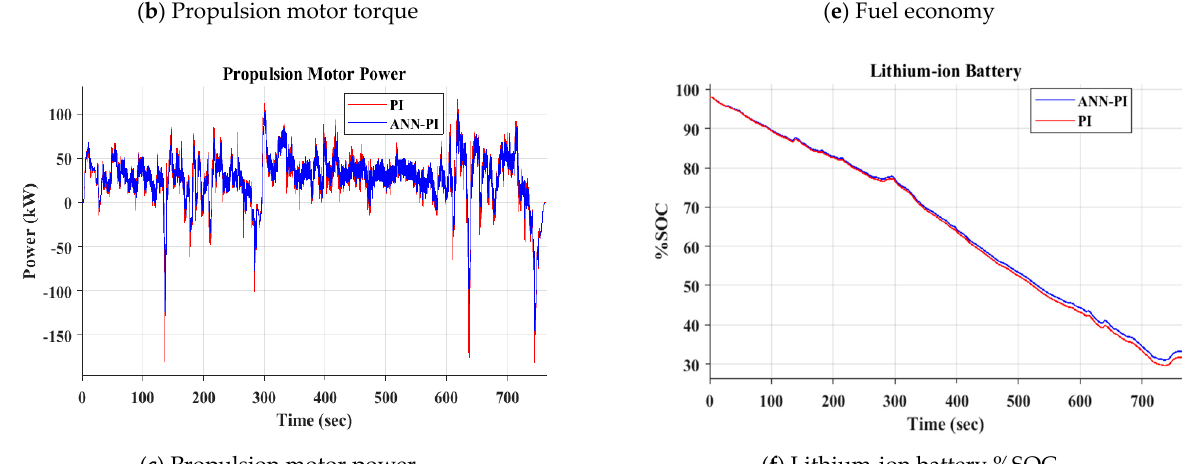
Figure 18. The performance of an eCAR with a conventional torque controller and an ANN tuned PI controller under a HWFET cycle.